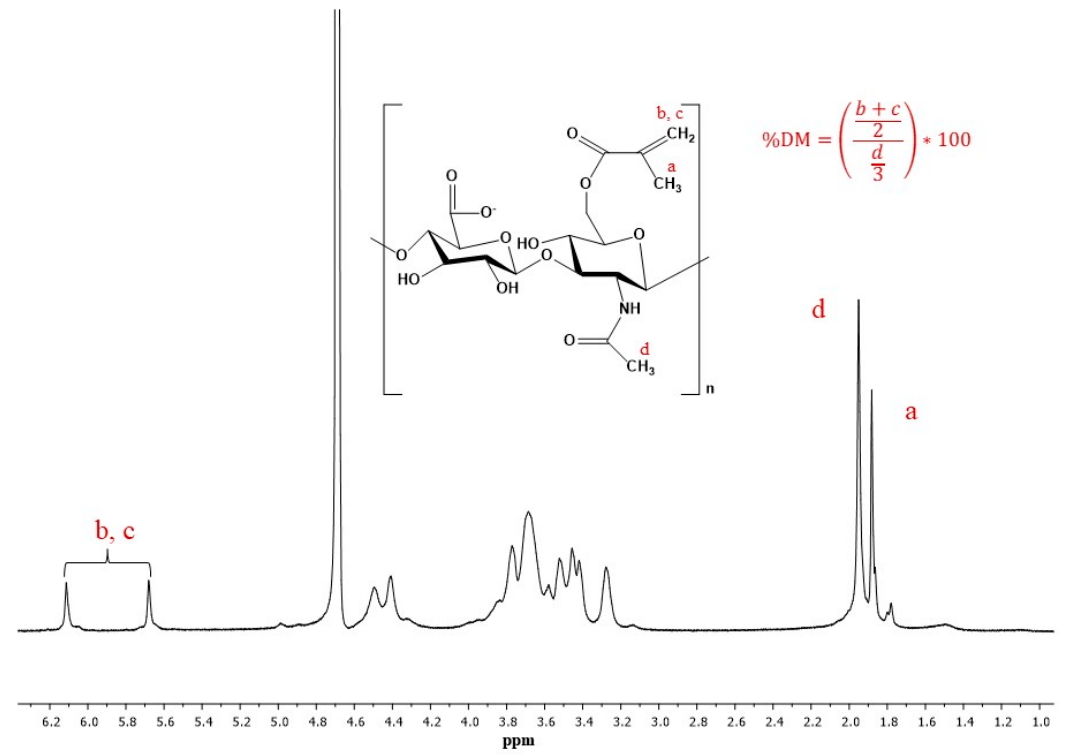
Figure 3. 1 H NMR spectrum of Figure 3 . 1 H NMR spectrum of MeHA.